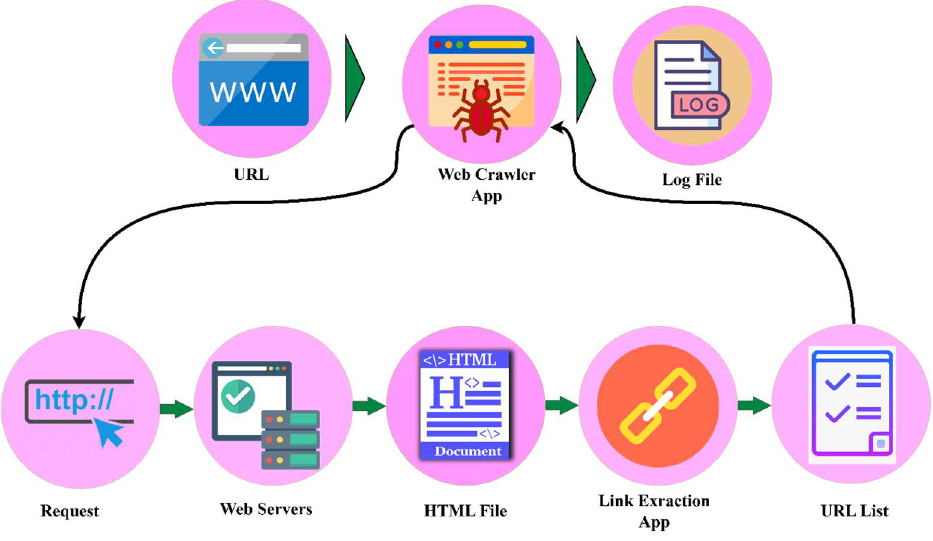
Figure 3. How web crawlers operate.